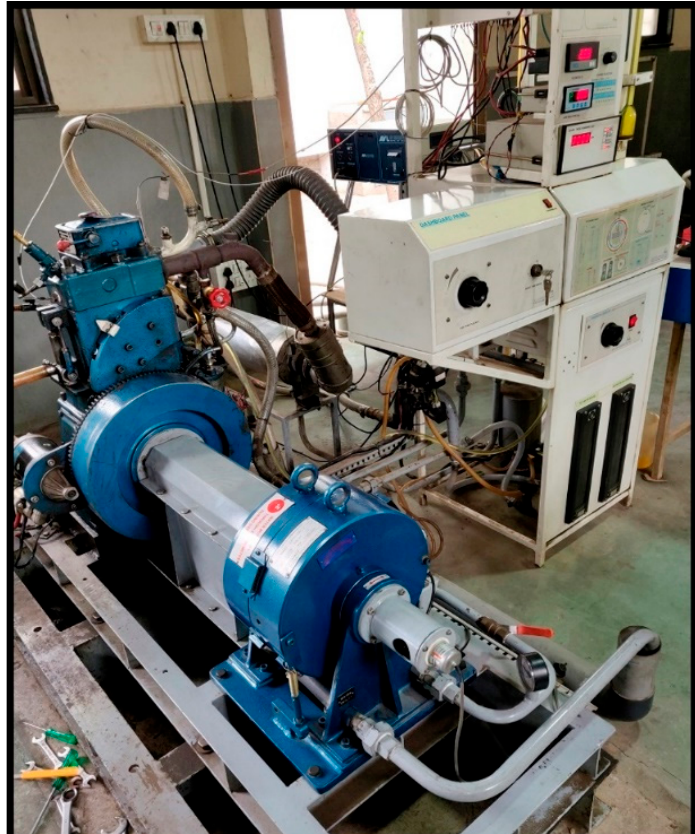
Figure 1. Photographic view of VCR engine. Table 3. Engine Specifications.